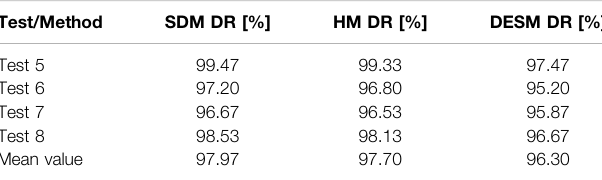
TABLE4| Testingphase.DRandmeanvaluesforSDM,HM,DESMachievedwith Test 5, 7, 7, 8 performed in Environment 2.